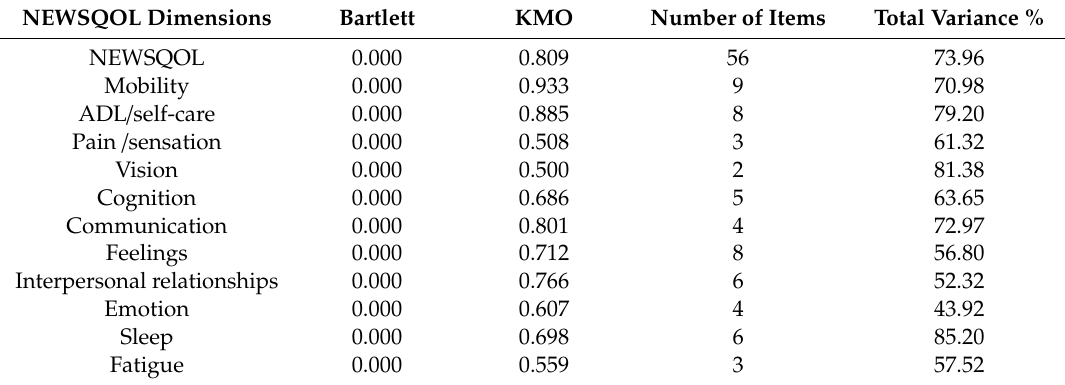
Table 3. Values of factorial construct validity of the Newcastle stroke-specific quality of life measure (NEWSQOL).